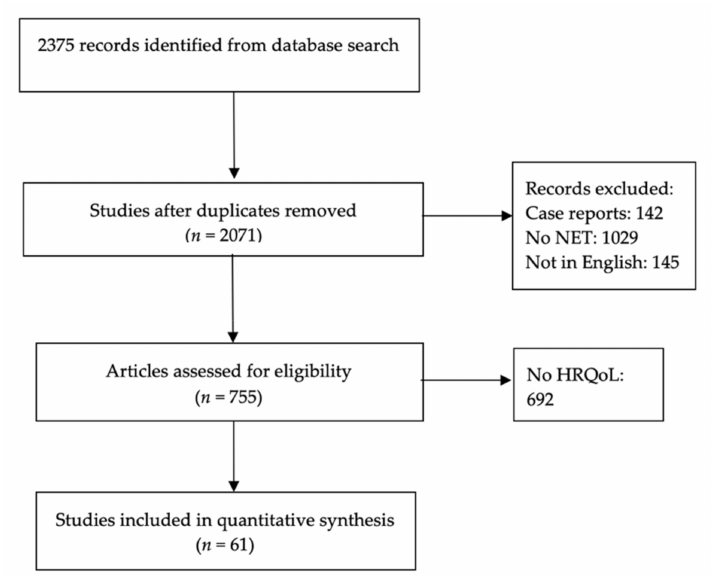
Figure 1. Flow chart describing systematic research search and study selection